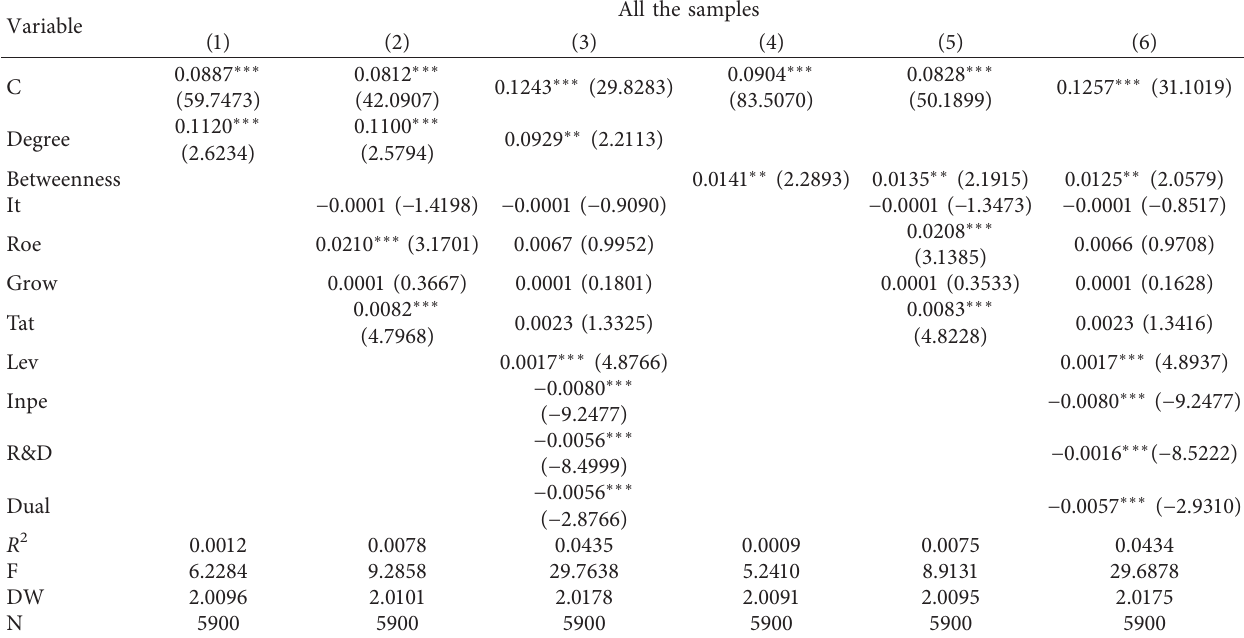
Table 4: Regression results: director networks and cost of equity